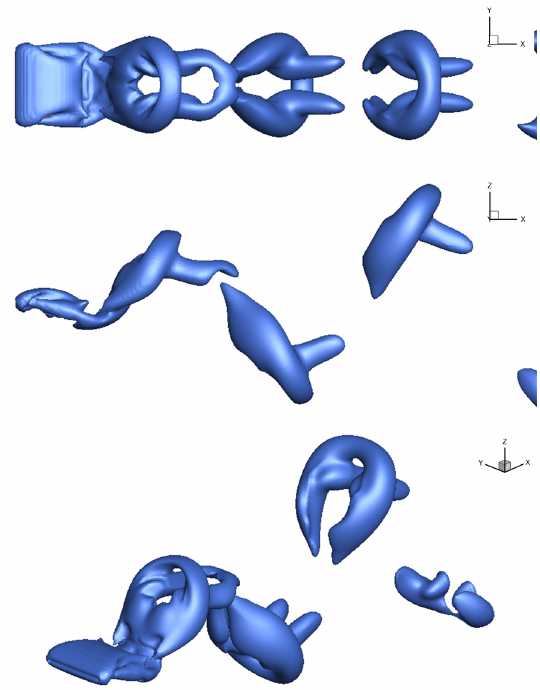
Figure 4. Vortical structure of the flow over an isolated flexible plate (Supplementary Video S1 is available